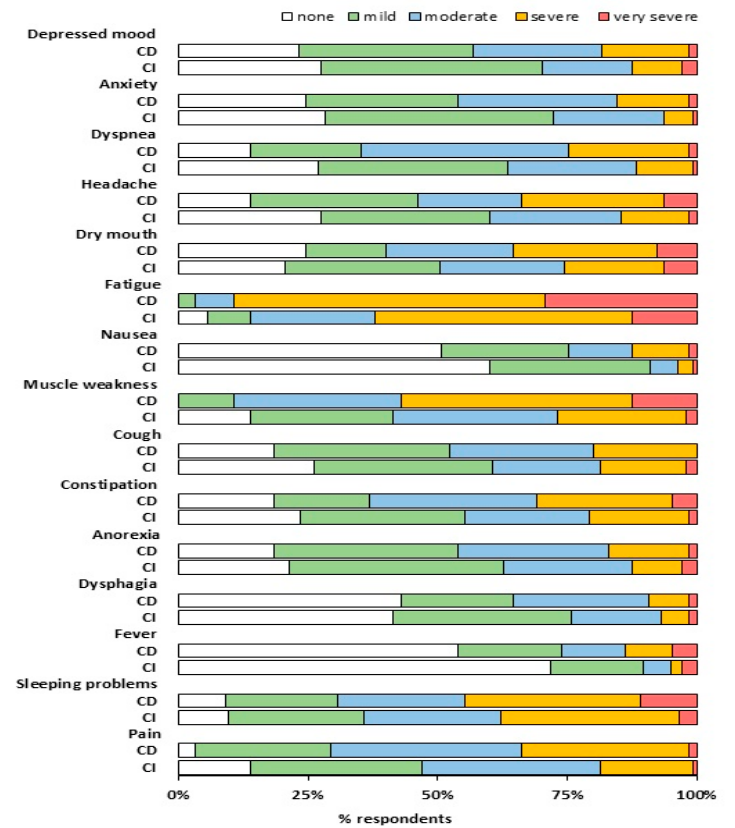
Figure 3. Symptom intensity for care-dependent (CD) and care-independent (CI) patients; care-dependent: Care Dependency Scale (CDS) score ≤ 68 points ( n = 65); care-independent: CDS score > 69 points ( n = 145). Symptom intensity based on Utrecht Symptom Diary score: none: 0 point; mild: 1–3 points; moderate: 4–6 points; severe: 7–9 points; and very severe: 10 points. Di ff erences in the proportion of patients across di ff erent symptom intensity categories between the CD patients and CI patients were tested with the McNemar